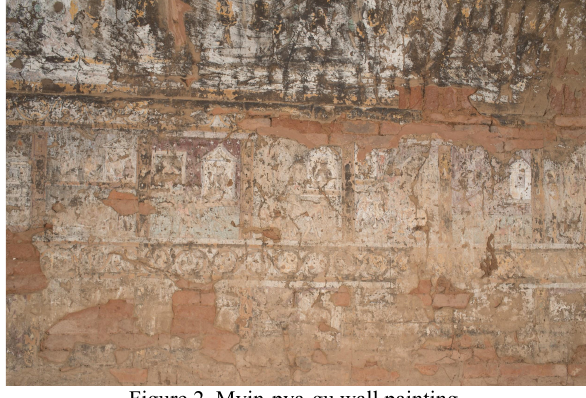
Figure 2. Myin-pya-gu wall